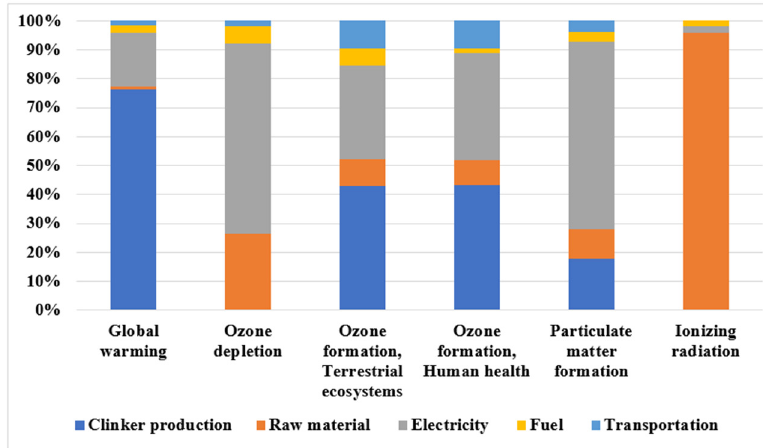
Figure 2. Contribution of each production stage to atmospheric impacts. Table 3. Processes studied in each production stage of Portland cement in South